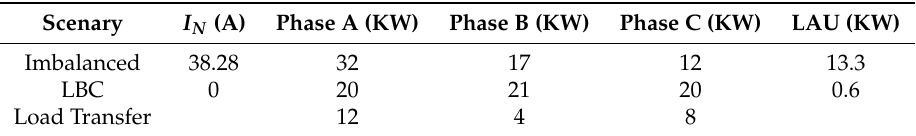
Table 5. LT-step